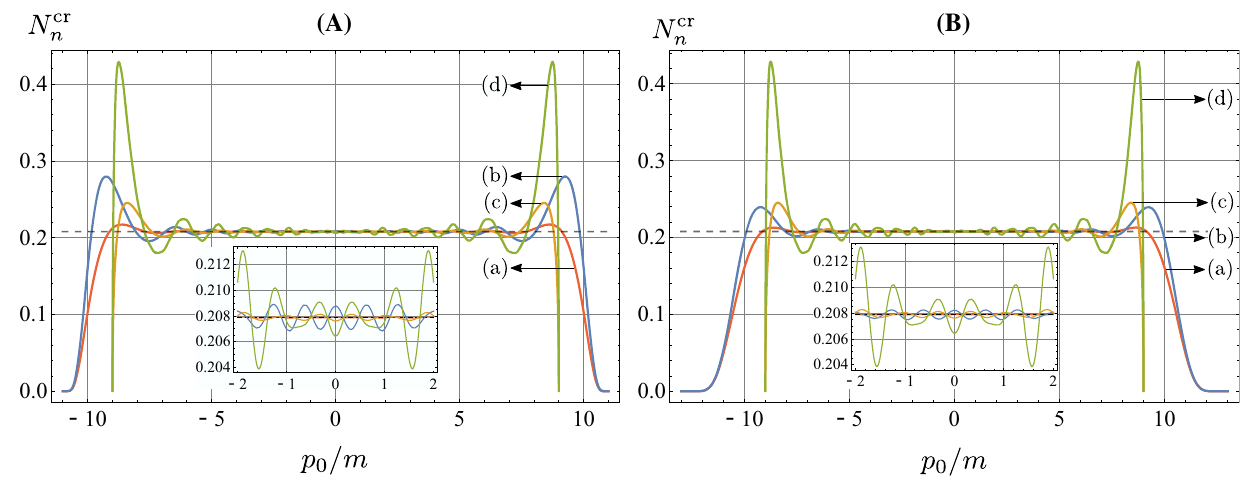
Fig. 10 Differential mean numbers N cr n of particles created from the vacuum by the composite electric field (106) [solid lines (a, b)] and by the L -constant electric field (105) [solid lines (c, d)] with fixed field amplitudes E = 2 E c and length mL = 10. In the left panel ( A ), m ξ 1 = m ξ 2 = 1 while in the right panel ( B ), m ξ 1 = m ξ 2 = 2.